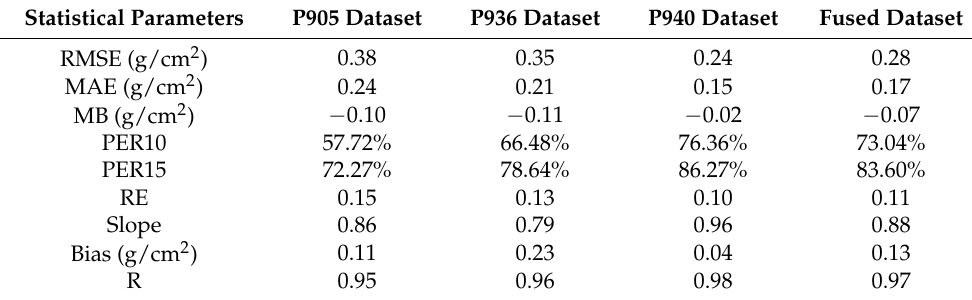
Table 2. Statistical parameters of four MERSI-2 PWV